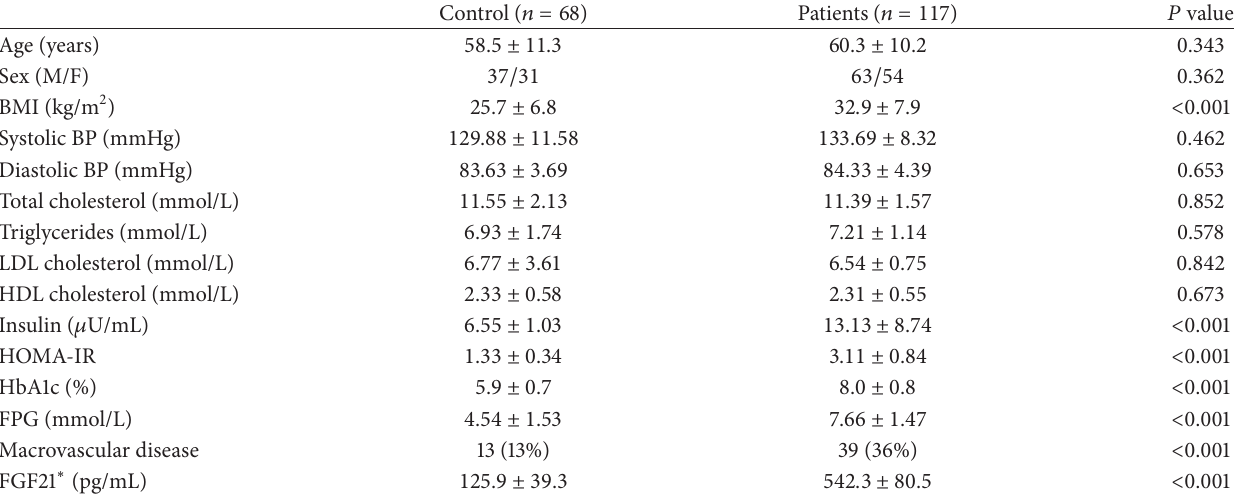
Table 1: Clinical and laboratory features of the patient and control groups. Values are means ( ± SD) or number